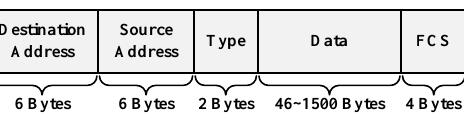
Figure 4. Frame format of Ethernet message.